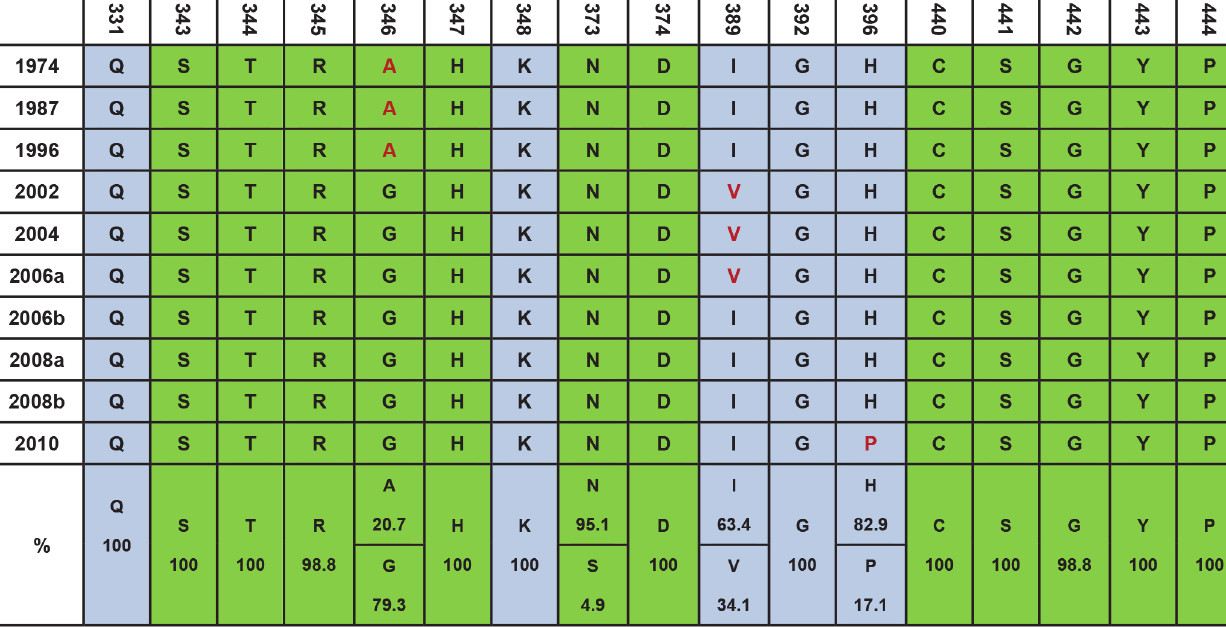
Fig 2. Analysis of HBGA-binding interfaces and the surrounding region for representative GII.4 strains. Ten representative sequences were selected from each major phylogenetic cluster from 1974 to 2012. The P domain sequences were aligned using MegAlign. Amino acids in green indicate residues that are required for HBGA binding. Light blue residues indicate amino acids that affect the binding specificity. Red letters indicate differences from the consensus sequence within the binding interfaces or surrounding regions. The percent similarity between all 82 strains is indicated at the bottom for key amino acids involved in HBGA